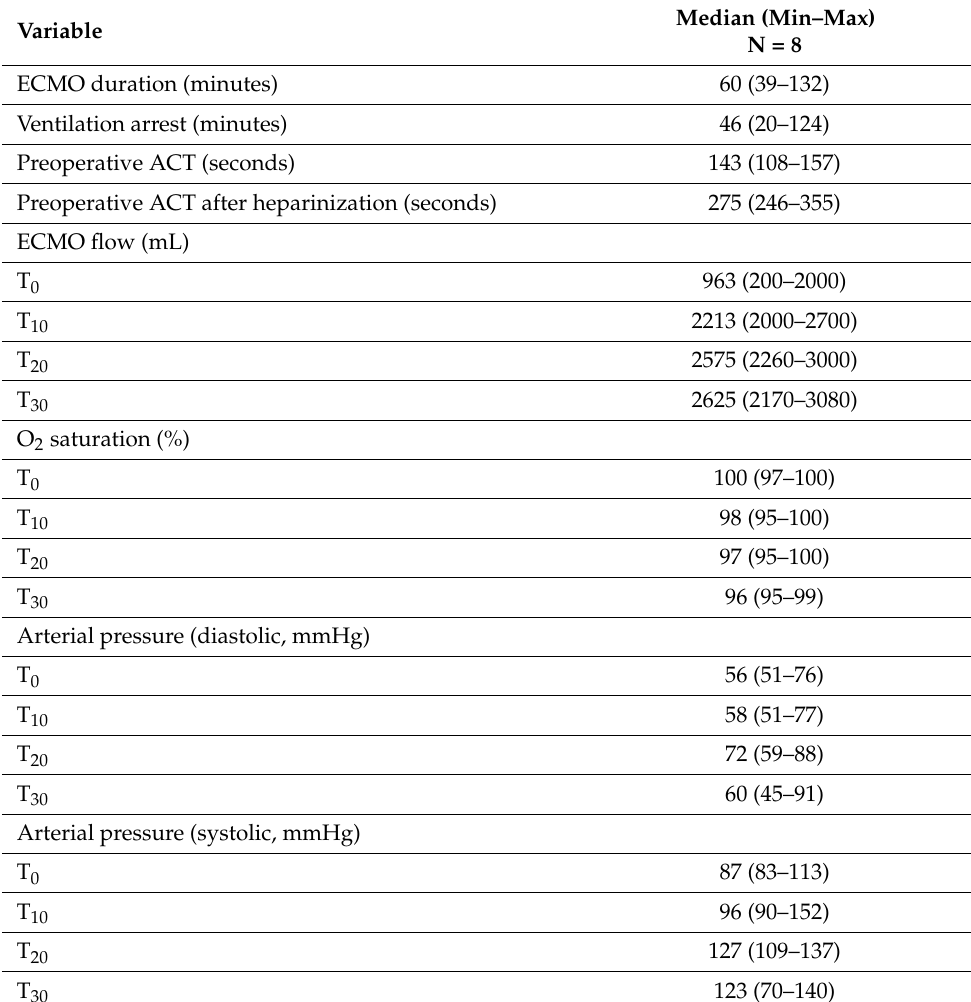
Table 2. Distribution of ECMO variables among patients with intraoperative ECMO (N =